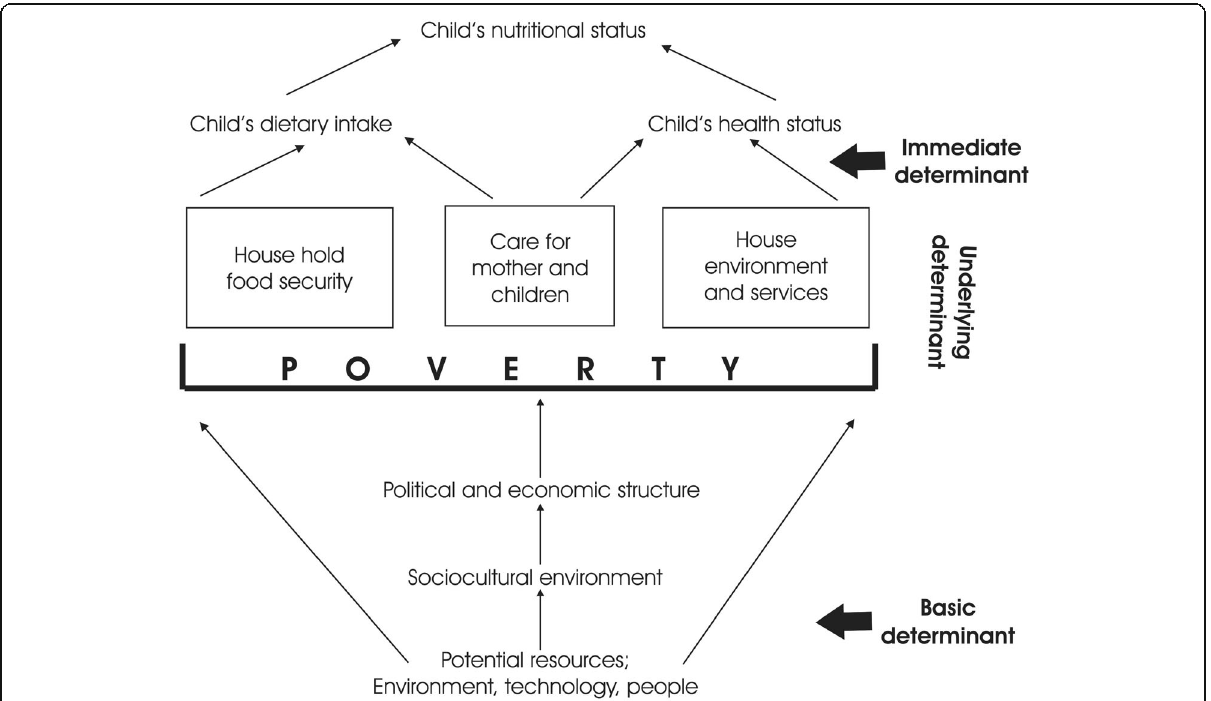
Fig. 1 Conceptual framework guiding empirical analysis by